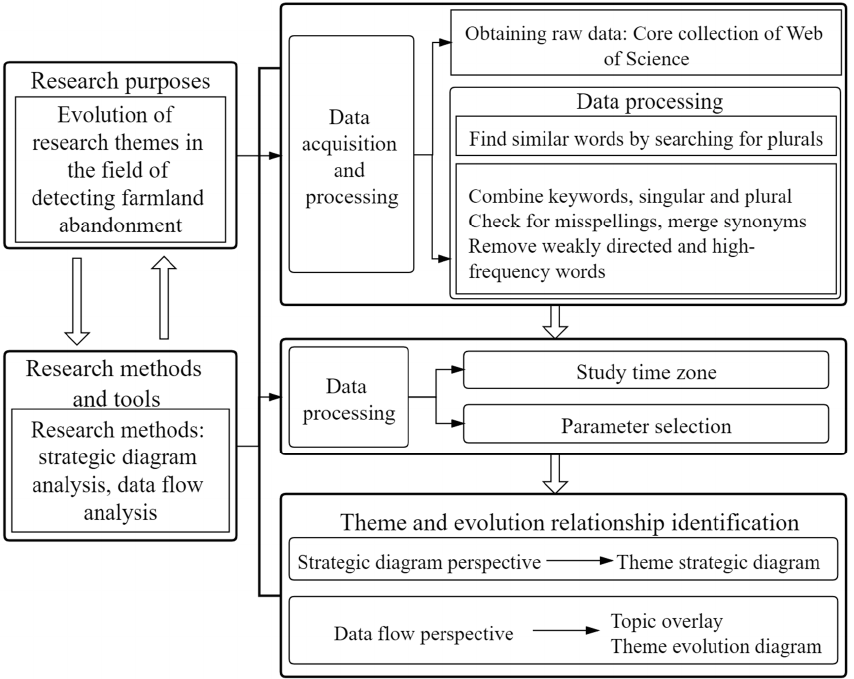
Figure 1. Farmland abandonment theme evolution path analysis framework.